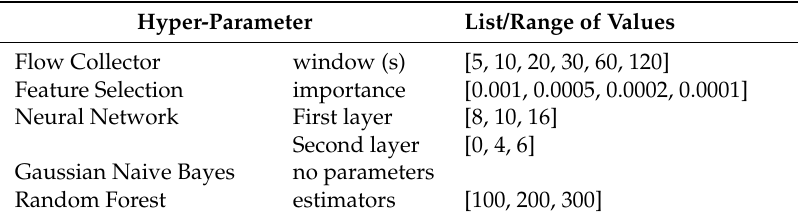
Table 6. Hyper-parameters tuned in the ransomware classifier selection